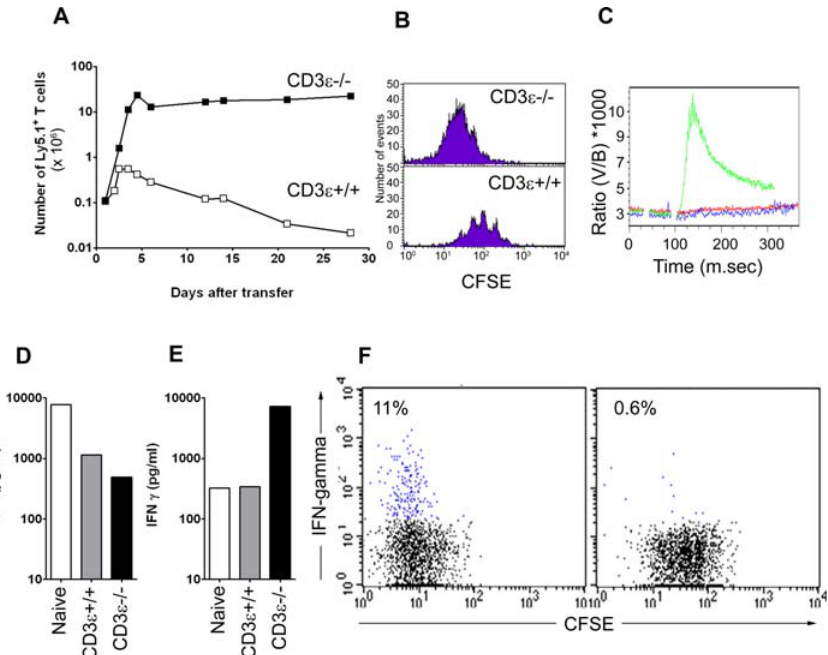
Figure 7. Poor Differentiation and Survival Are Superimposed on Adaptive Tolerance in the Presence of Endogenous T Cells (A) The total recovery of Ly5.1 þ 5C.C7 T cells from lymph nodes and spleen of recipient mice, various days after transfer into a T cell–replete (mPCC þ ,CD3 e þ ; open squares) host are compared with the recovery from a T cell–deficient (mPCC þ ,CD3 e (cid:1) / (cid:1) ; filled squares) transfer recipient. (B) Carboxy fluorescein succinimidyl ester profiles of transferred Ly5.1 þ 5C.C7 T cells, 3 d after transfer into a lymphopenic (top) or T cell–replete (bottom) PCC transgenic host. (C) Ly5.1 þ ,5C.C7 T cells, recovered 9 d after transfer to a T cell–replete PCC transgenic (red line) or T cell–deficient PCC transgenic (blue line) host, were loaded with Indo-1 and stimulated as described in Materials and Methods. The influx of calcium, measured as the ratio of violet to blue fluorescence, is compared to that of naı¨ve 5C.C7 T cells (green line). (D) IL-2 or (E) IFN- c secretion from sorted Ly5.1 þ ,5C.C7 T cells restimulated in vitro with 10 l M MCC peptide and irradiated syngeneic splenocytes for 48 h, 15 d after residence in a T cell–replete (gray bars) or T cell–deficient (black bars) PCC transgenic hosts. Naı¨ve 5C.C7 T cells (white bars) were used for comparison. (F) Ex vivo IFN c secretion by transferred T cells recovered 4 d after transfer to a T cell–replete (right) or T cell–deficient (left) PCC transgenic host. FACS plots are gated on CD4 þ , 7AAD-ve cells in the lymphocyte